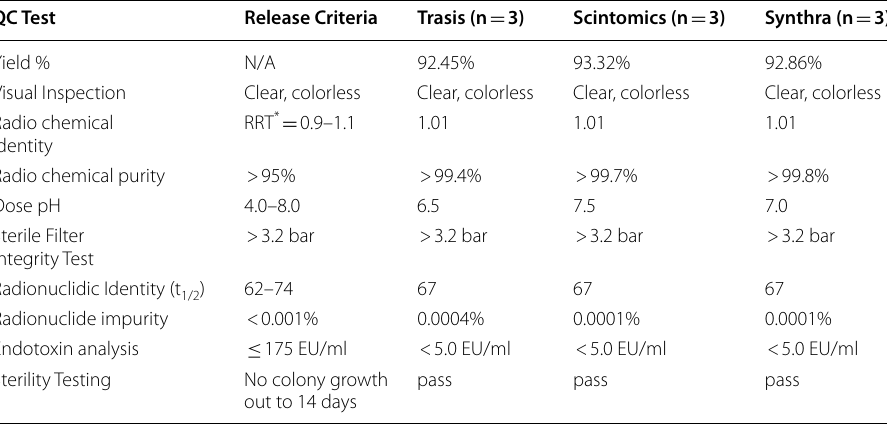
Table 1 Summary of the product specifications for 50 μg FAPI-46, n